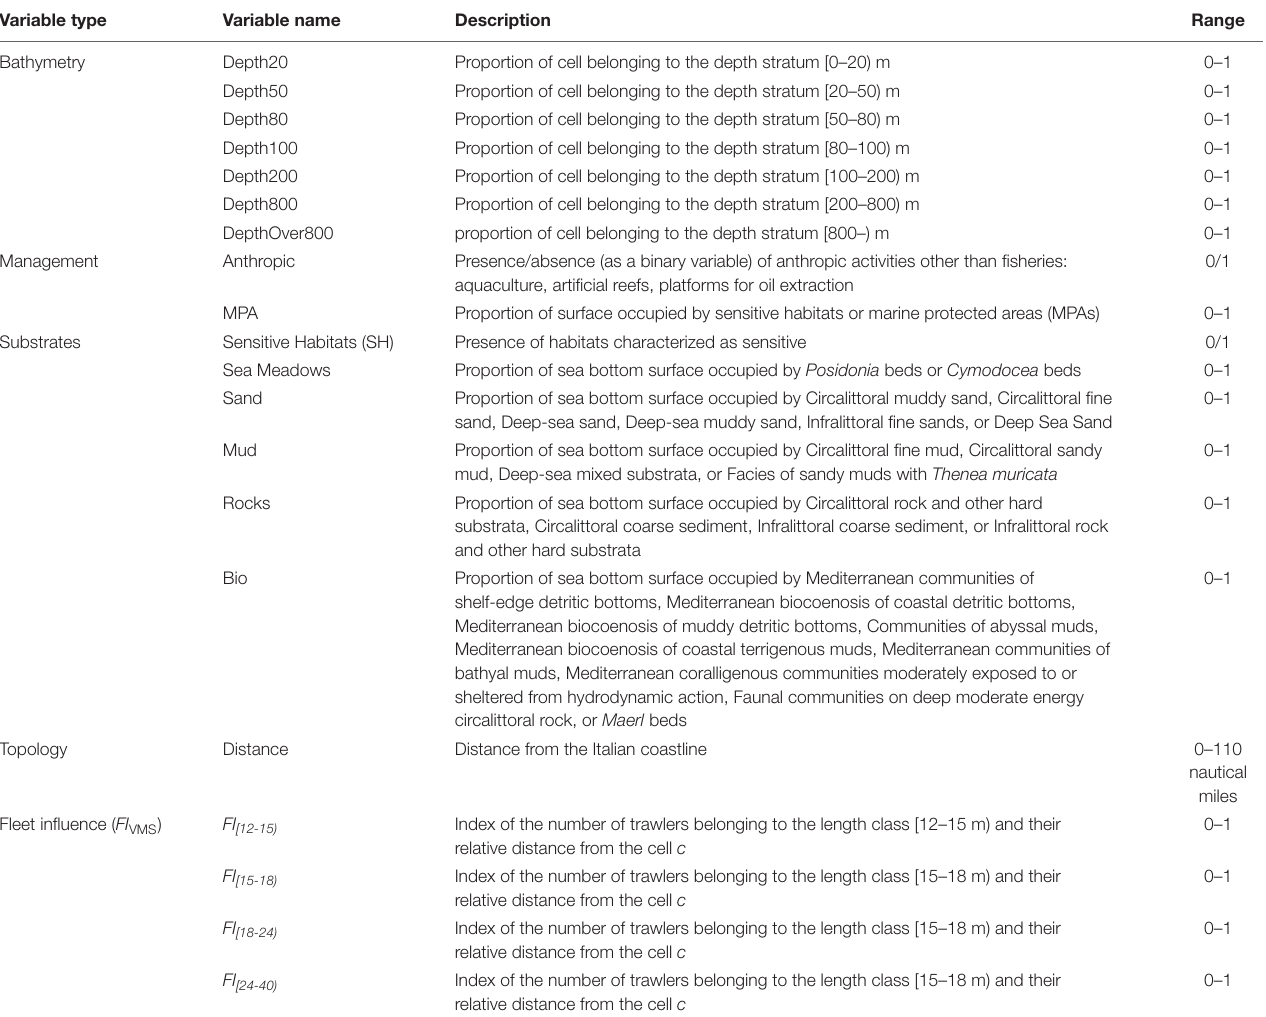
TABLE 1 | List of input variables used for training of